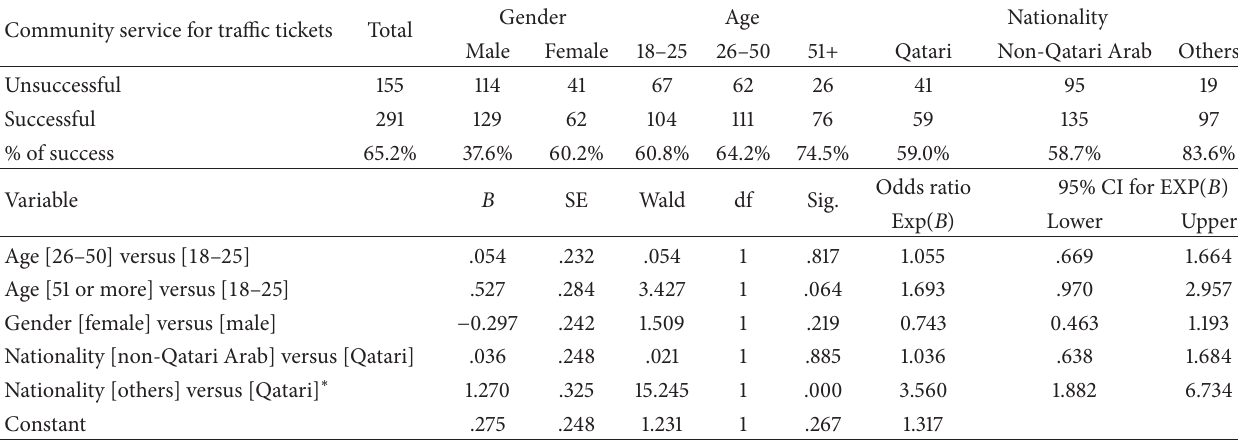
Table 10: Reported success and logistic model results for the community service for traffic tickets